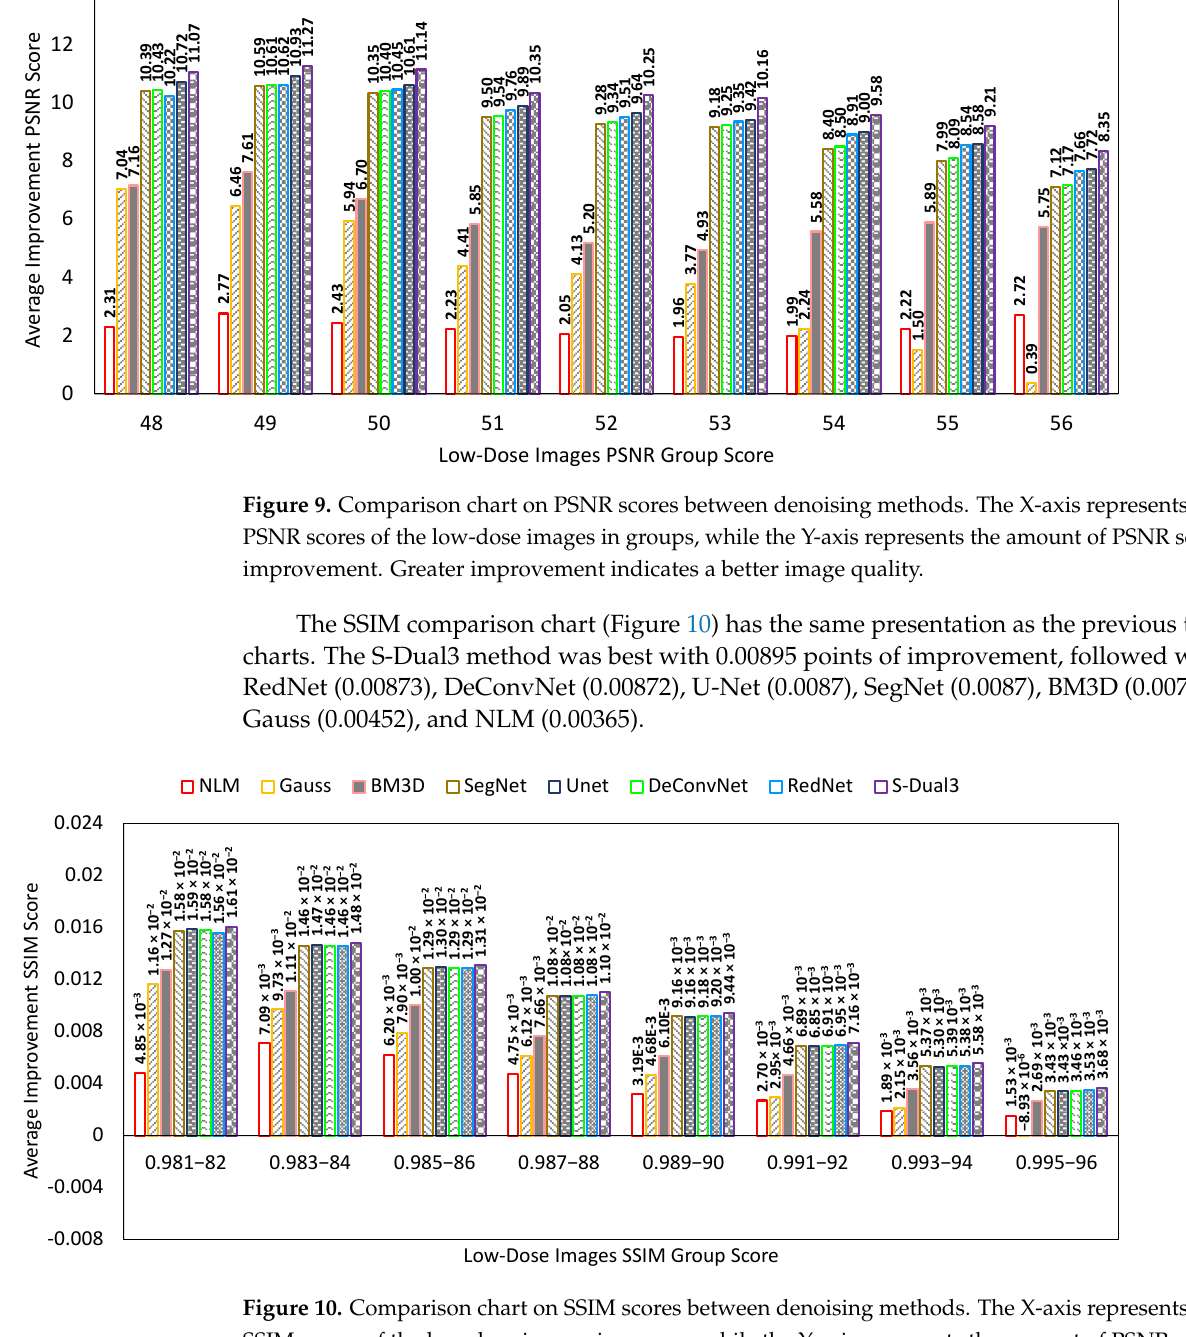
Figure 10. Comparison chart on SSIM scores between denoising methods. The X-axis represents the SSIM scores of the low-dose images in groups, while the Y-axis represents the amount of PSNR score improvement. Greater improvement indicates a better image